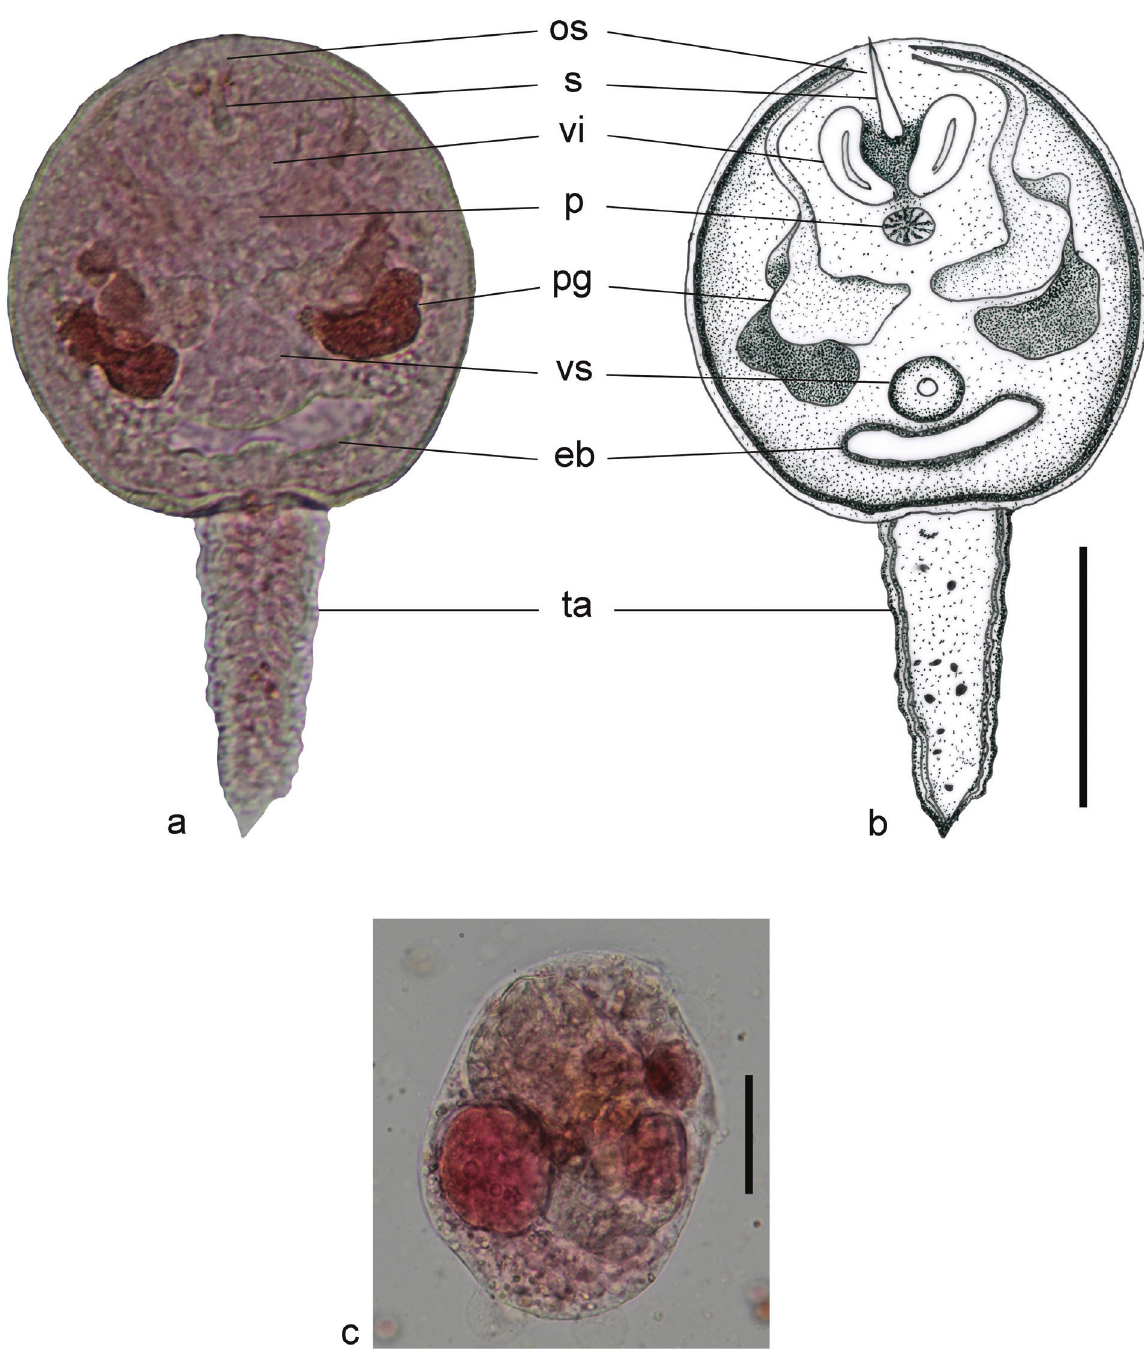
Figure 5. Acanthatrium histaense Koga, 1953. a . specimen stained with 0.5% neutral red. b . drawing of cercaria. c . sporocyst stained with 0.5% neutral red. Abbreviations – eb: excretory bladder; os: oral sucker; s: stylet; p: pharynx; pg: penetration gland; ta: tail; vi: virgulate organ; vs: ventral sucker. Scale bars: 50